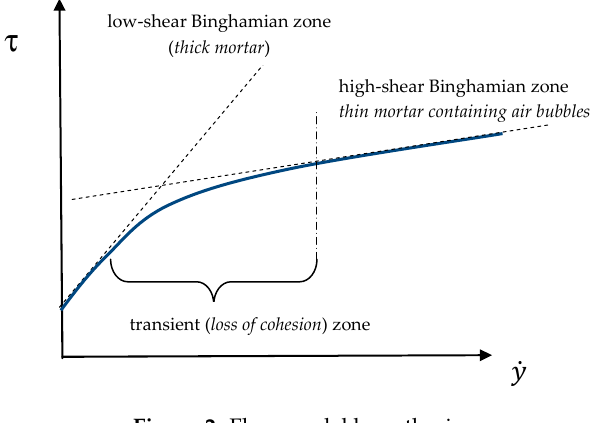
Figure 2. Flow model hypothesis.